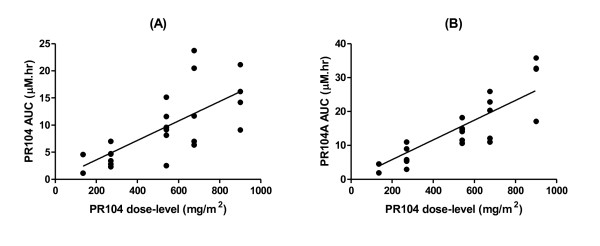
Linear relationship between PR-104 dose-level and PR-104 (A) and PR-104A exposure (B).